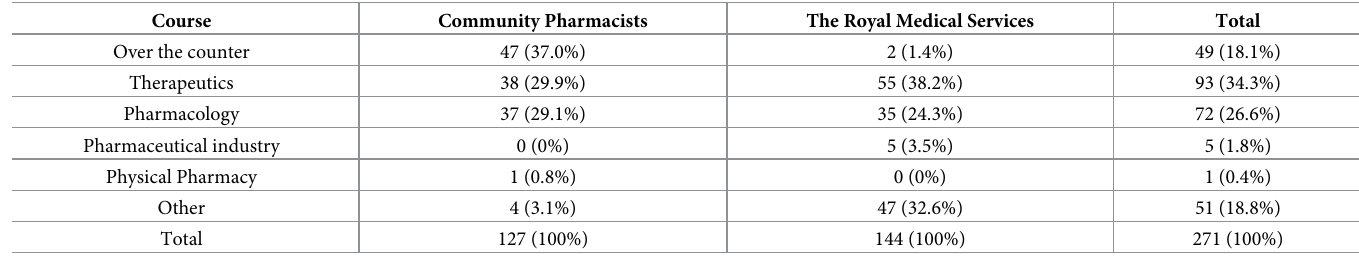
Table 9. Traditional modules which mostly were used after